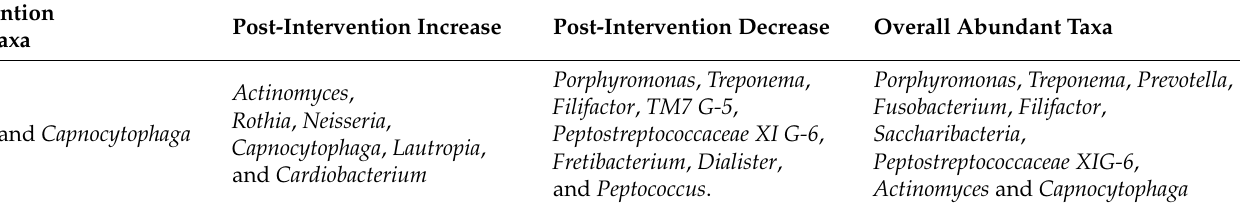
Table A3. The relative abundances of